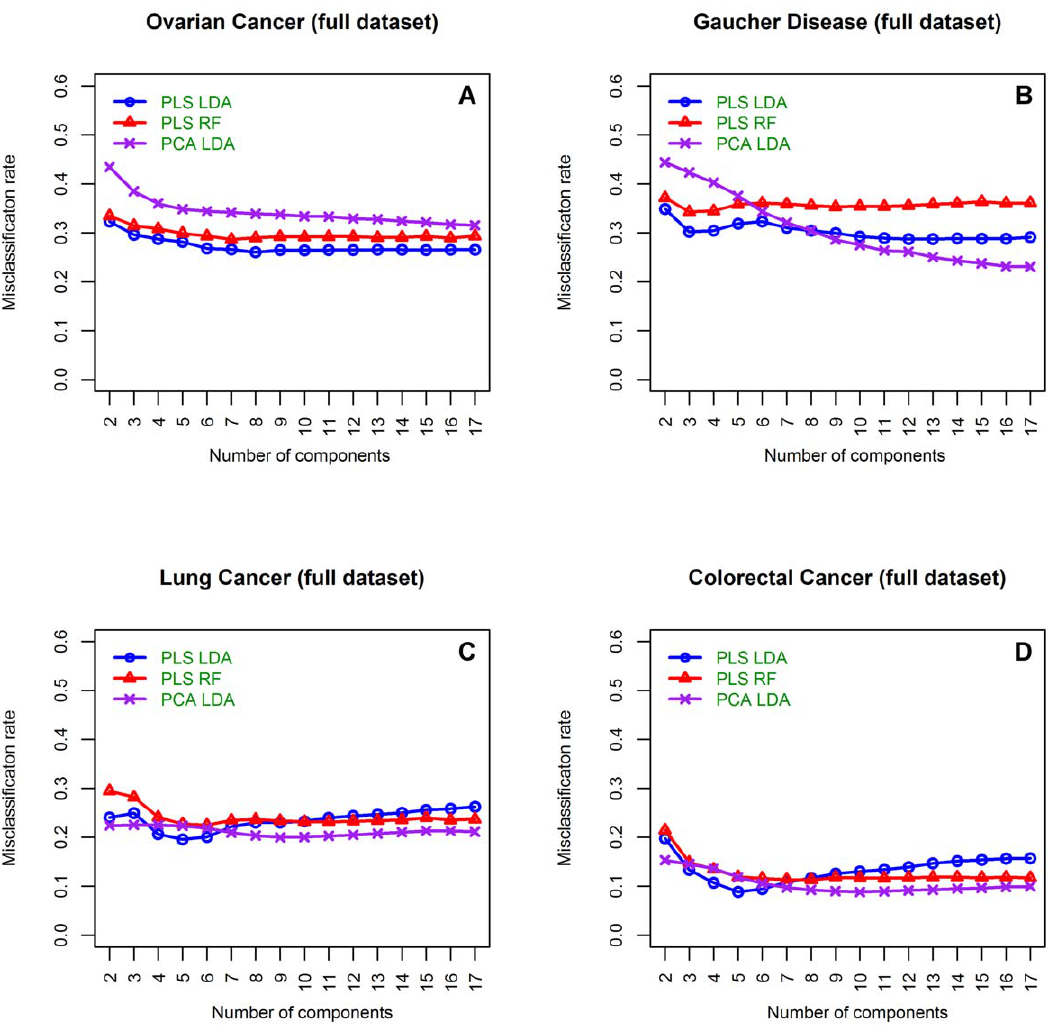
Figure 1. Misclassification rates of dimension reduction classifiers using the untrimmed datasets. Mean misclassification rates for each of the dimension reduction-based methods using the full dataset (all variables) in the dataset to build the classification model. A ) Is from the OC dataset [16], B ) is from the Gaucher disease dataset [46], C ) is from the LC datasets and D ) is from the CRC dataset [14]. Blue circles illustrate PLS-LDA classification results, red triangles are from a PLS-RF classifier and purple crosses show results obtained from a PCA-LDA